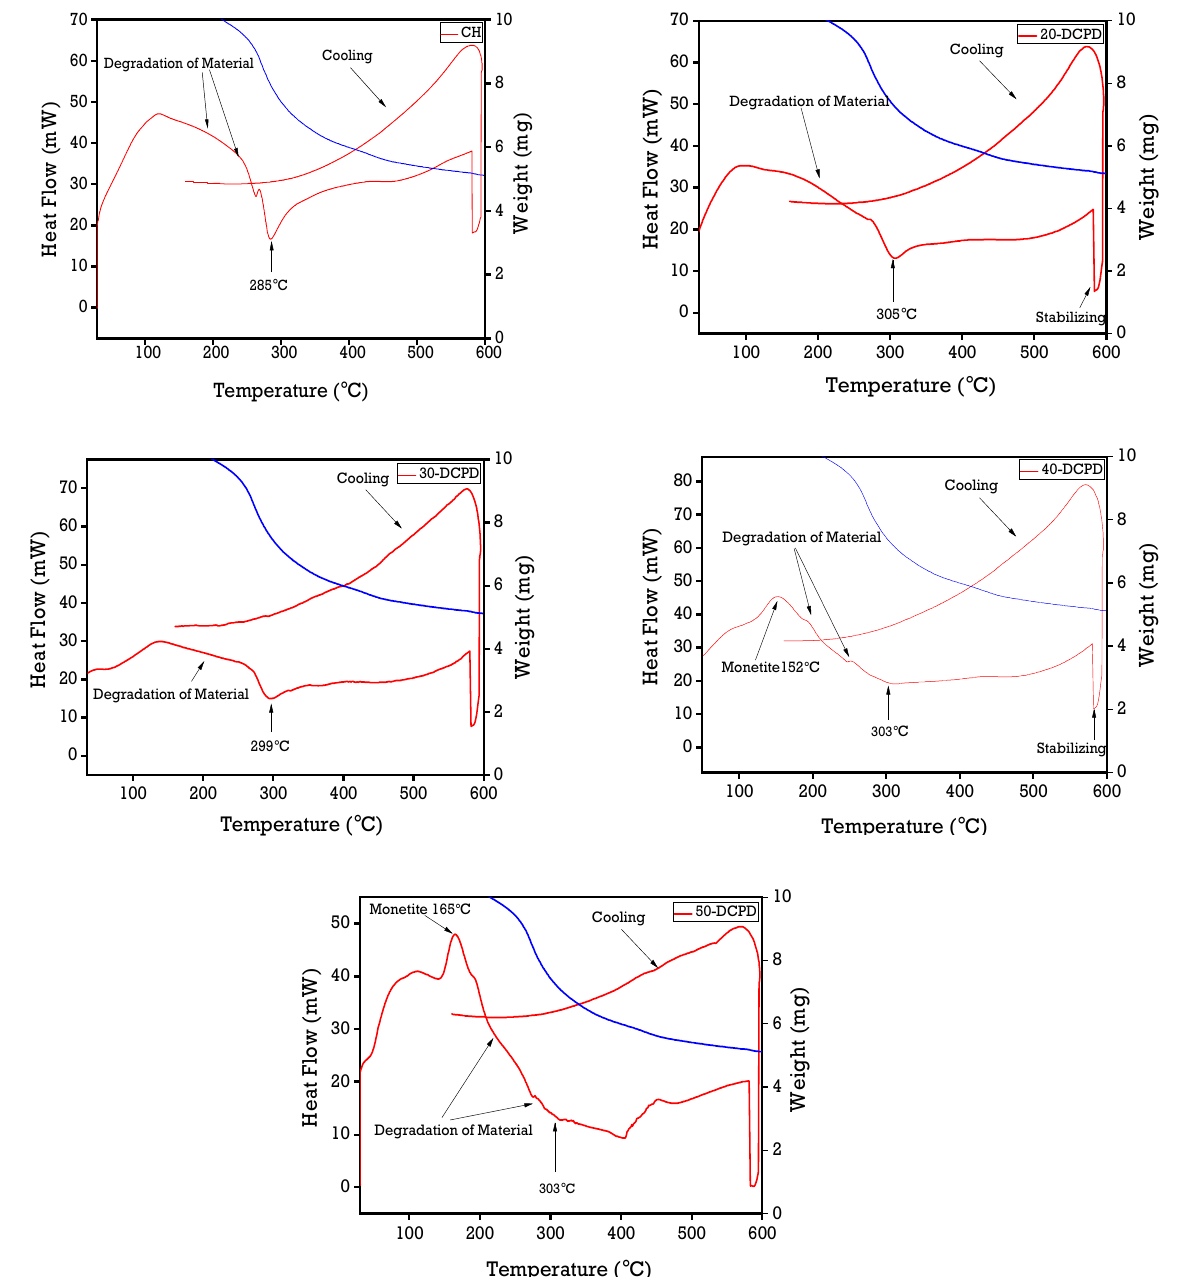
Figure 4. Thermal analysis of high molecular weight freeze-dried chitosan scaffolds using the Perkin Elmer STA 8000 from 30 to 600°C at a heating and cooling rate of 20°C/min. The red line refers to the heat flow, while the blue line refers to the mass change of the sample.